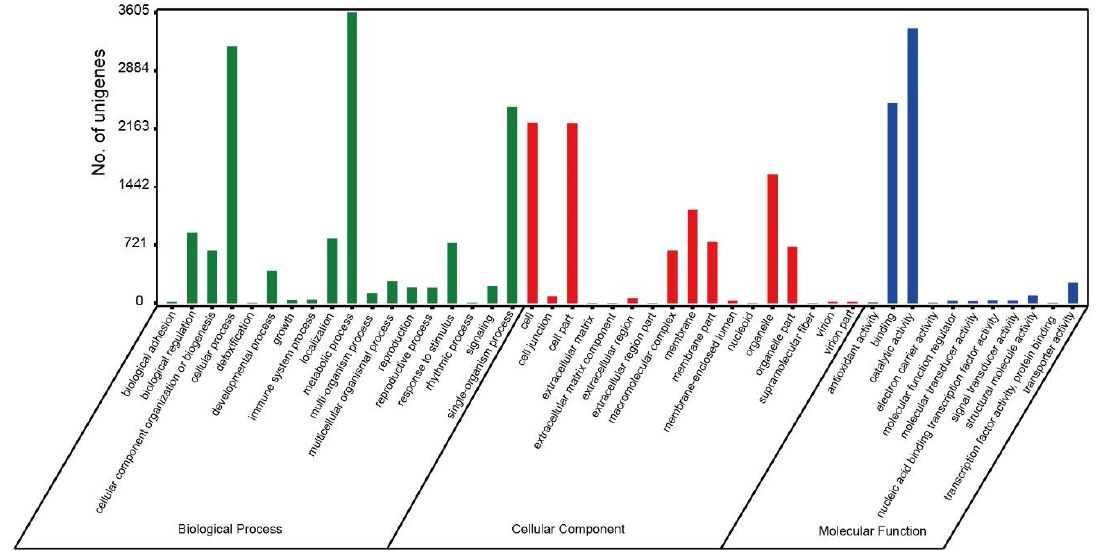
Figure 4. Function classification of the gene ontology of all unigenes based on Nr annotation.